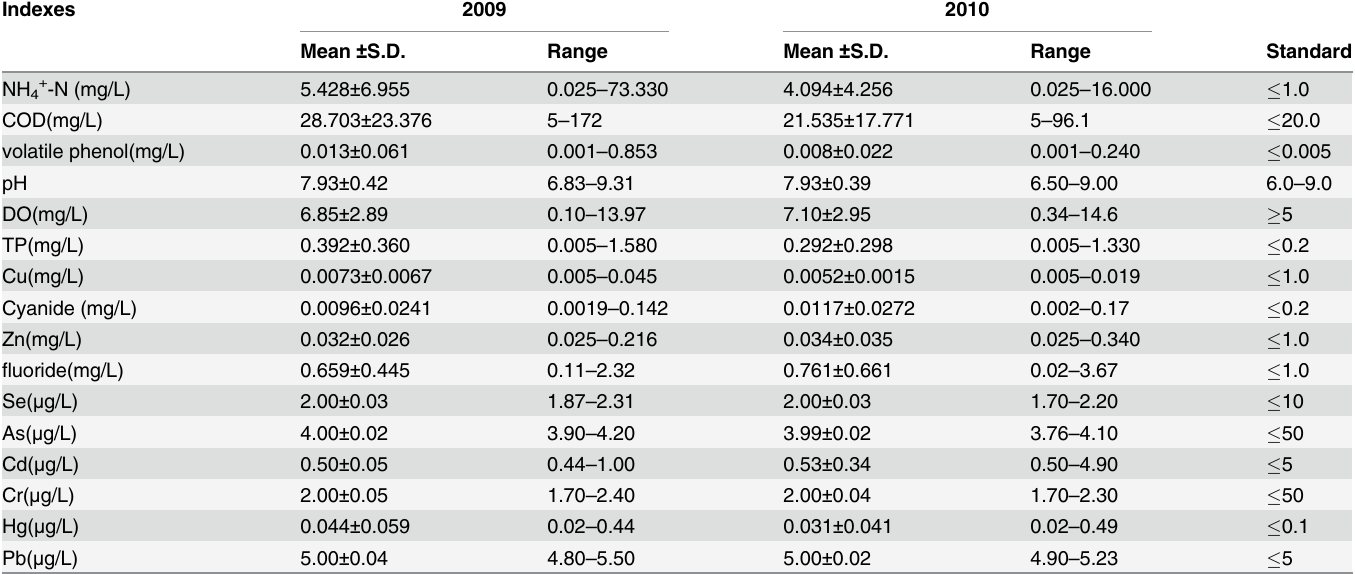
Table 1. Water characteristics of Taizihe River for data collected at seventeen sites between 2009 and